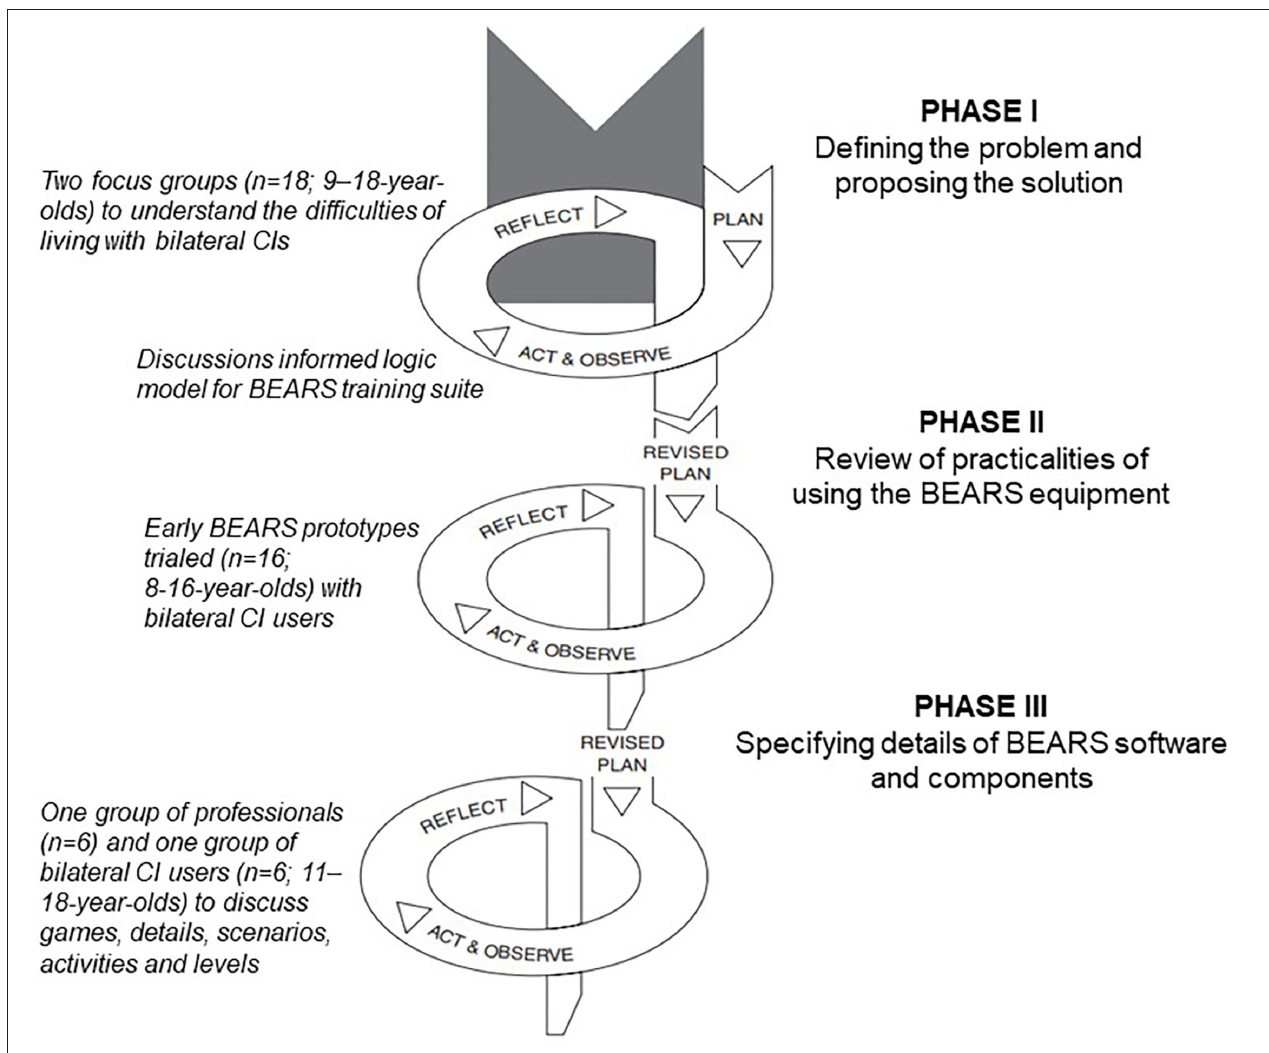
FIGURE 1 | The cycles for the three participatory design